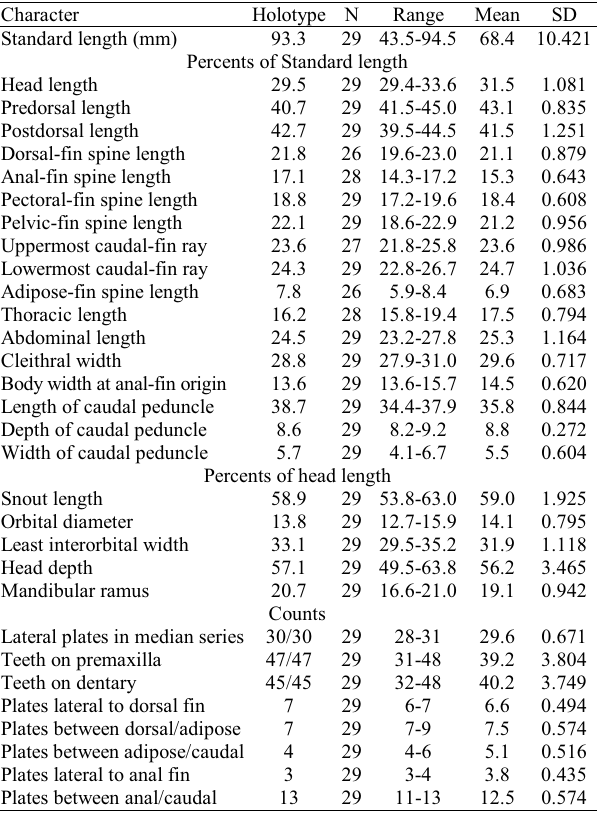
Table 1. Descriptive morphometrics and meristics of Pareio- rhaphis parmula . Values are given as ranges for all measured specimens. Standard length is expressed in mm.